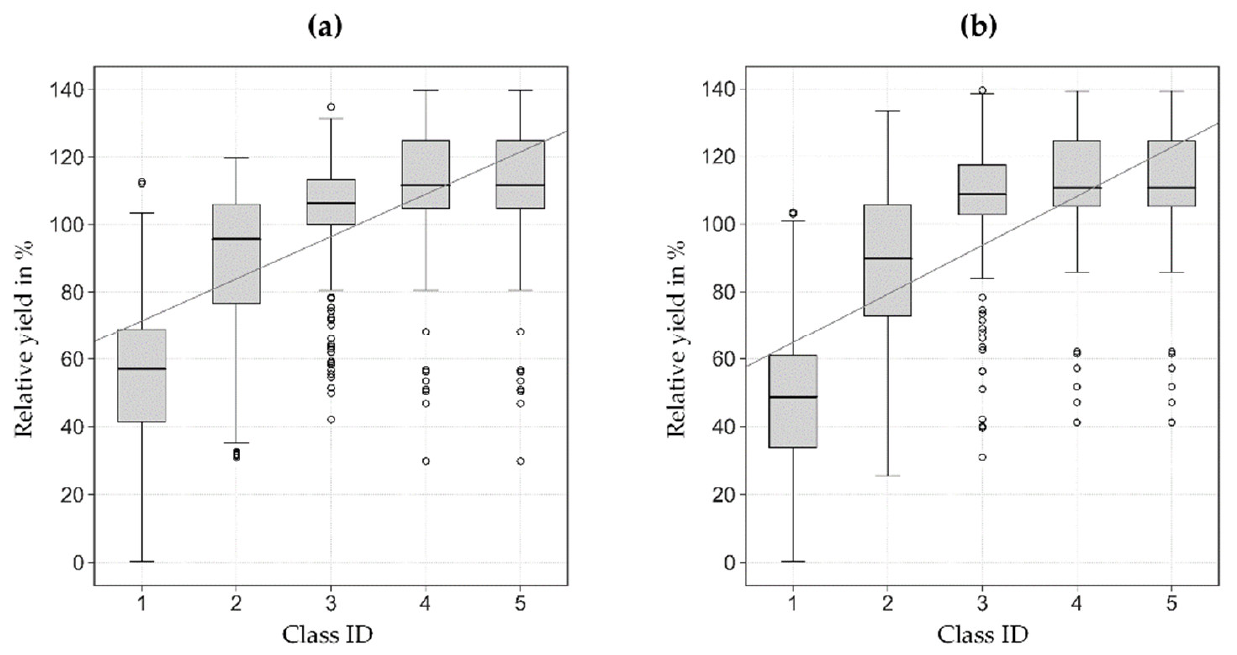
Figure 12. Boxplots of stratified sampling for model-1 for fertilizations at 25 March 2020 ( a ) and 21 April 2020 ( b ). The white circles out of the whiskers show outliers.